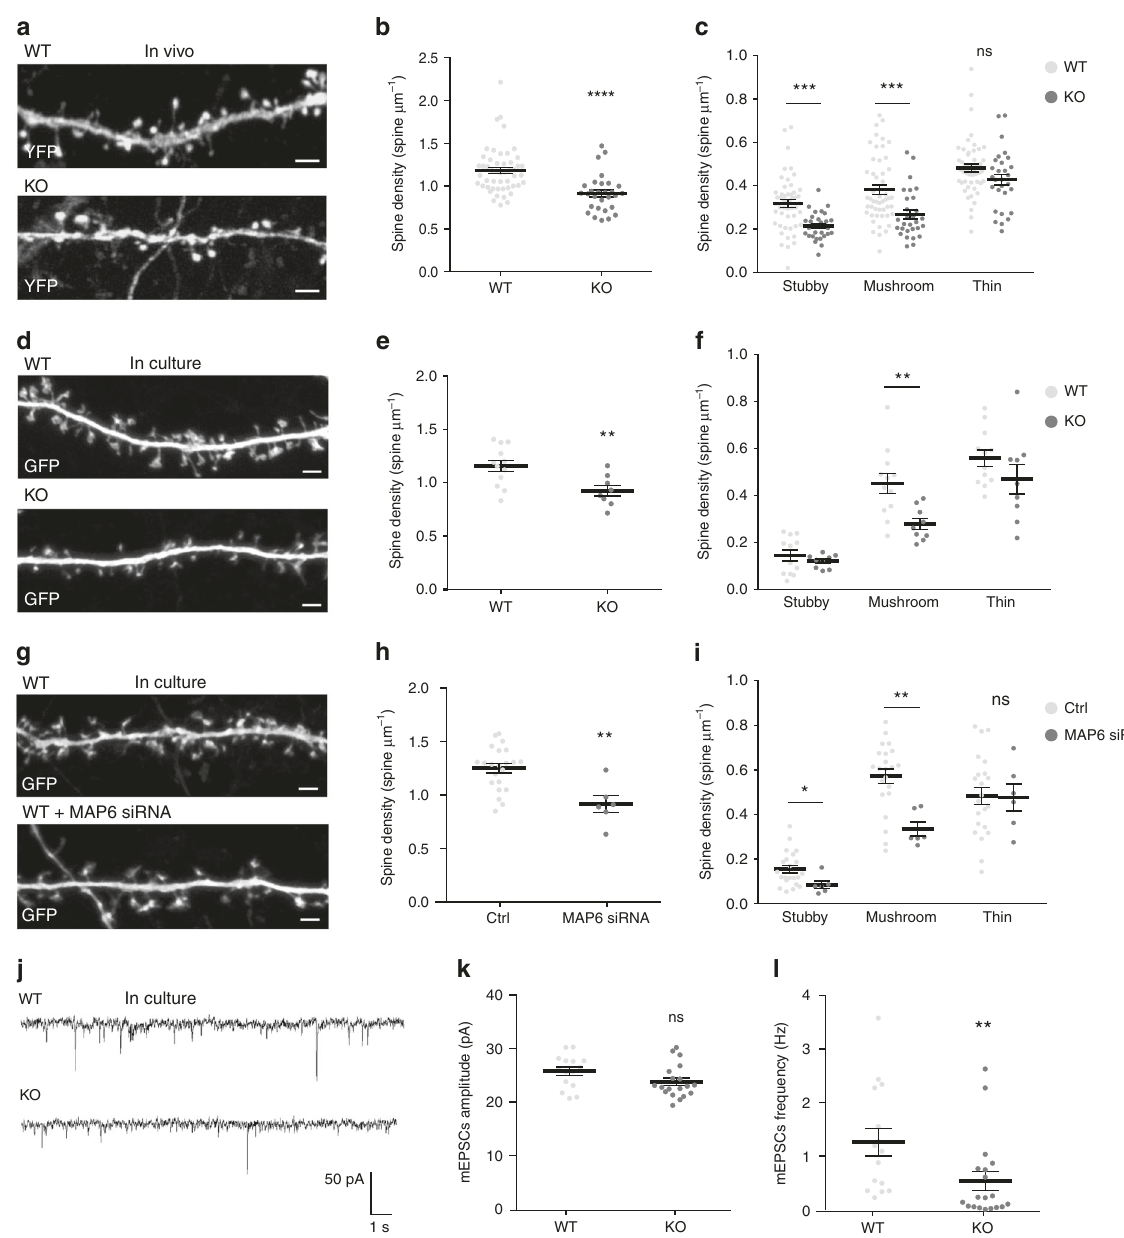
Fig. 1 MAP6 inhibition reduces dendritic spine density. a Confocal image showing representative examples of dendritic segments of layer 5 cortical neurons of WT and MAP6 KO Thy1 -eYFP-H mice. Scale bar: 2 μ m. b , c Graphs of dendritic spine density in apical secondary or tertiary dendrites. The total density ( b ), or that of each morphological spine type ( c ) in WT and MAP6 KO Thy1 -eYFP-H neurons are represented as mean ± SEM (ns: not signi fi cant, *** p < 0.001; Student ’ s t -test), n = 50 neurons/ 4 WT animals and 29 neurons/ 4 KO animals. d Confocal image showing representative examples of dendritic segments of WT and MAP6 KO hippocampal neurons in culture at 18 DIV, transfected with GFP-expressing vector. Scale bar: 2 μ m. e , f Graphs of total dendritic spine density ( e ) or density by shape type ( f ) in WT and MAP6 KO cultured neurons. Values are represented as mean ± SEM (ns: not signi fi cant, *** p < 0.001 Student ’ s t -test), n = 12 neurons/ 3 WT embryos and 9 neurons/ 3 KO embryos, respectively. g Confocal image showing representative examples of dendritic segments of 18 DIV cultured hippocampal WT neurons transfected with GFP-expressing vector and control siRNA or MAP6 siRNA. Scale bar: 2 μ m. h , i Graphs of total dendritic spine density ( h ) or density by shape type ( i ) in neurons transfected with control or MAP6 siRNA. Values are represented as mean ± SEM (ns: not signi fi cant, * p < 0.05; ** p < 0.01; Student ’ s t -test), n = 22 neurons/ 4 embryos and 6 neurons/ 3 embryos from control and siRNA treated neurons, respectively. j Sample traces showing mEPSCs of WT and MAP6 KO 18 DIV cultured hippocampal neurons. k , l Graphs of the mean mEPSCs amplitude ( k ) and frequency ( l ) recorded in WT or MAP6 KO cultured neurons. Values are represented as mean ± SEM (ns: not signi fi cant, ** p < 0.01; Student ’ s t -test), n = 15 neurons/ 5 WT embryos and 19 neurons/ 3 KO embryos, respectively. For each experiment of